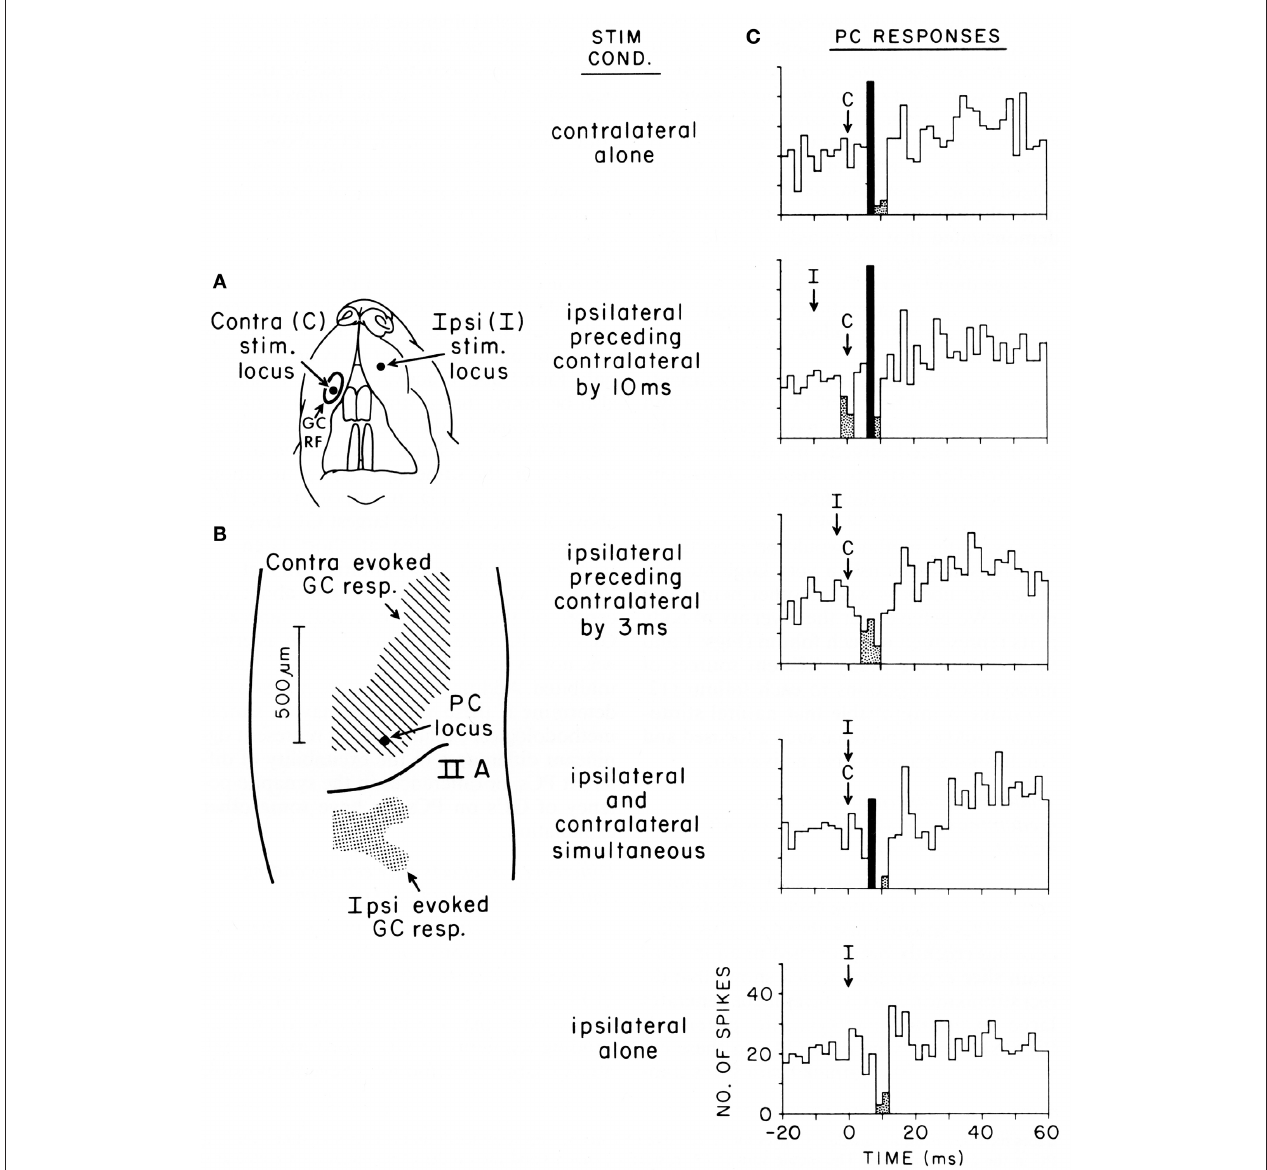
Figure 5 | Purkinje cell responses to cotemporaneous peripheral stimuli activating two adjacent regions of the granule cell layer in Crus iiA of the rat. (A) This figurine shows the location of the contralateral (C) and ipsilateral (I) upper lip foci stimulated in this experiment. (B) Shows the areas of the granule cell layers that responded to stimulation of each location. This figure also shows the location of the Purkinje cell whose responses to stimulation of different